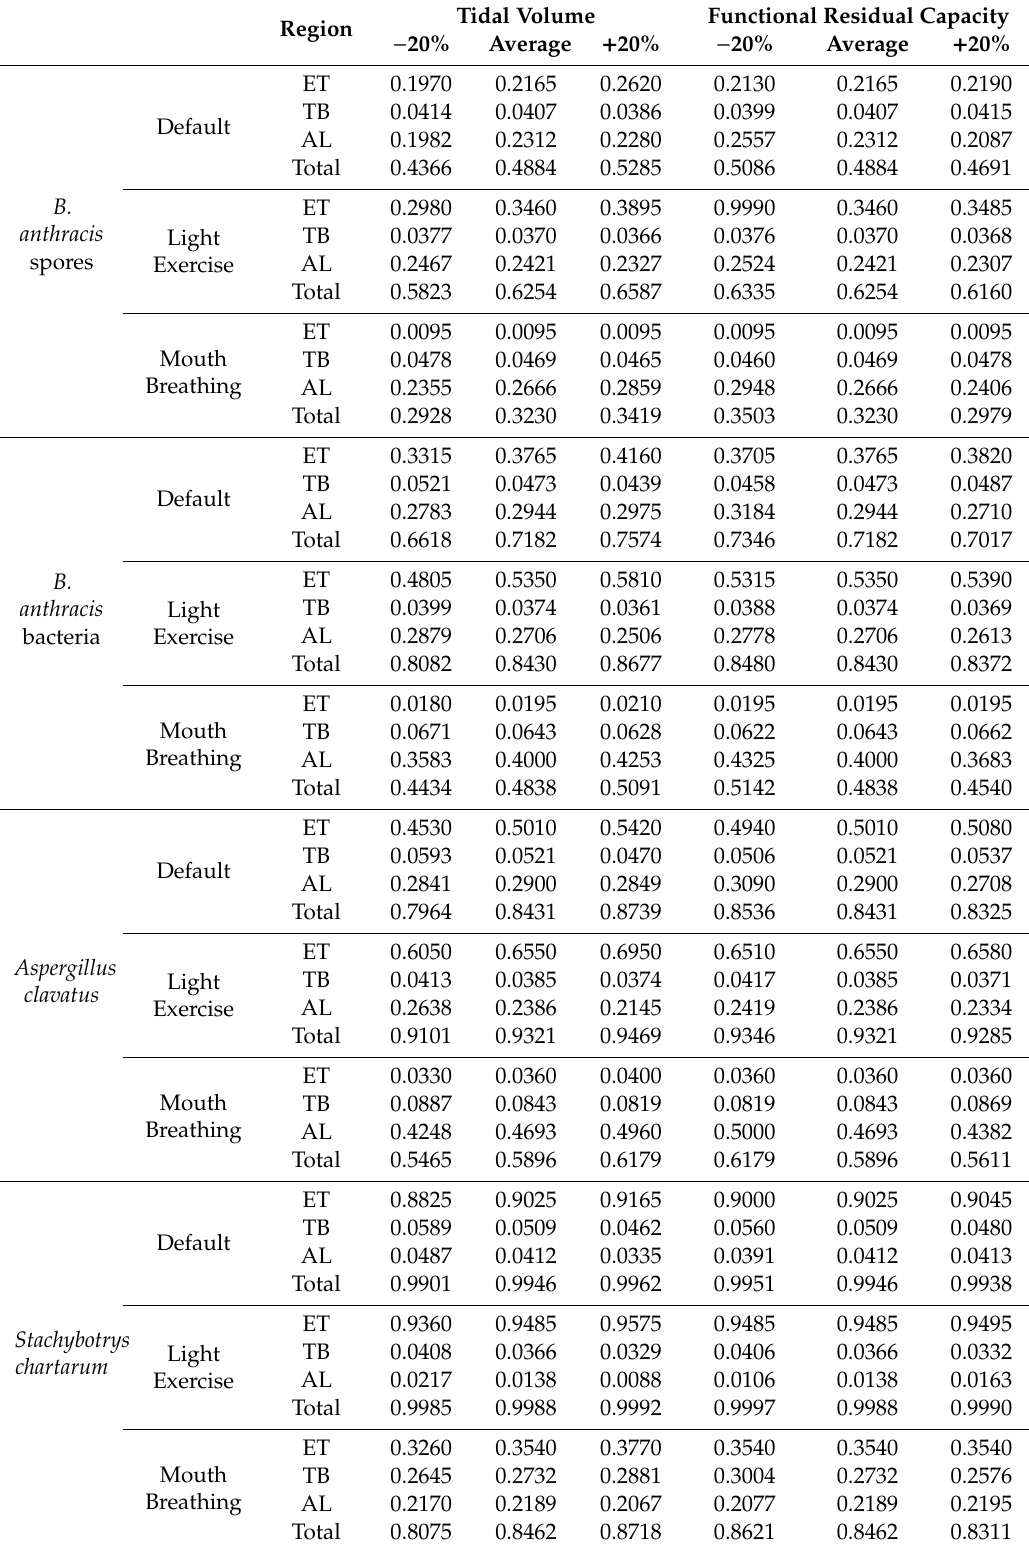
Table 3. Deposition fractions as calculated by the e ff ect of the age-specific model with input values ± 20% from values calculated by BAIL for each